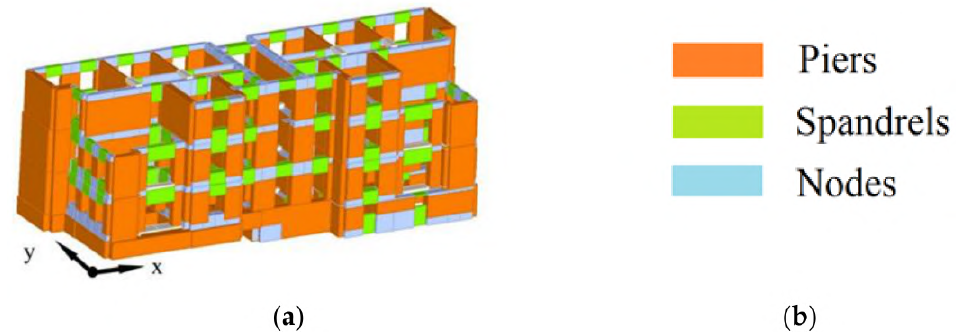
Figure 11. ( a ) A 3D view of the model; ( b ) legend of the model